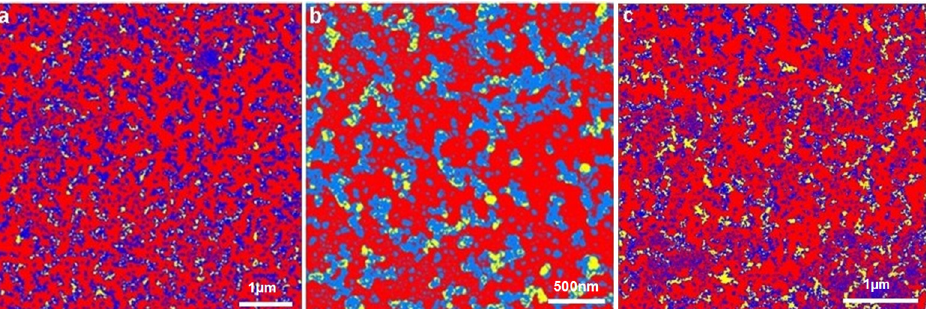
Figure 10. Analysis of Al 3 (Sc,Zr) and MgZn 2 precipitates distribution in the microstructure, and volume fraction of precipitates in the alloy containing 0.1%Sc under thermomechanical treatment (the yellow regions are Al 3 (Sc,Zr) precipitates and the blue regions are MgZn 2 precipitates) with: ( a ) MD30, ( b ) CD50, and ( c ) MD50 samples.